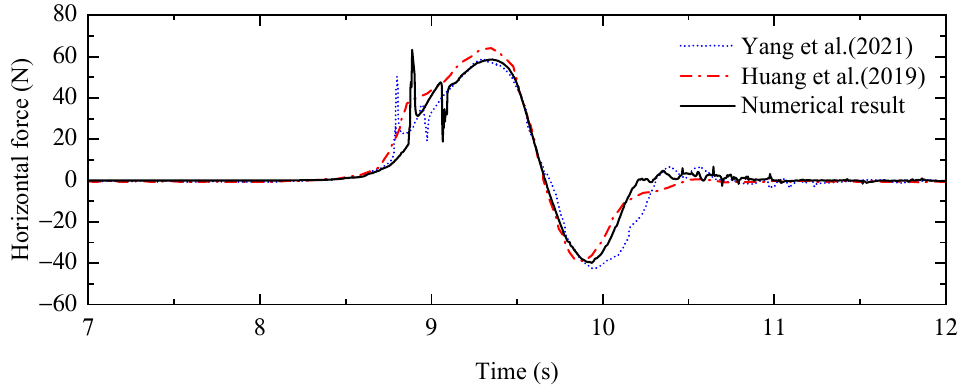
Figure 6. Horizontal force comparison with experimental results and numerical simulation results. Figure 6. Comparison of horizontal force between the numerical result, the experimental result of Huang et al. [45] and the numerical result of Yang et al.